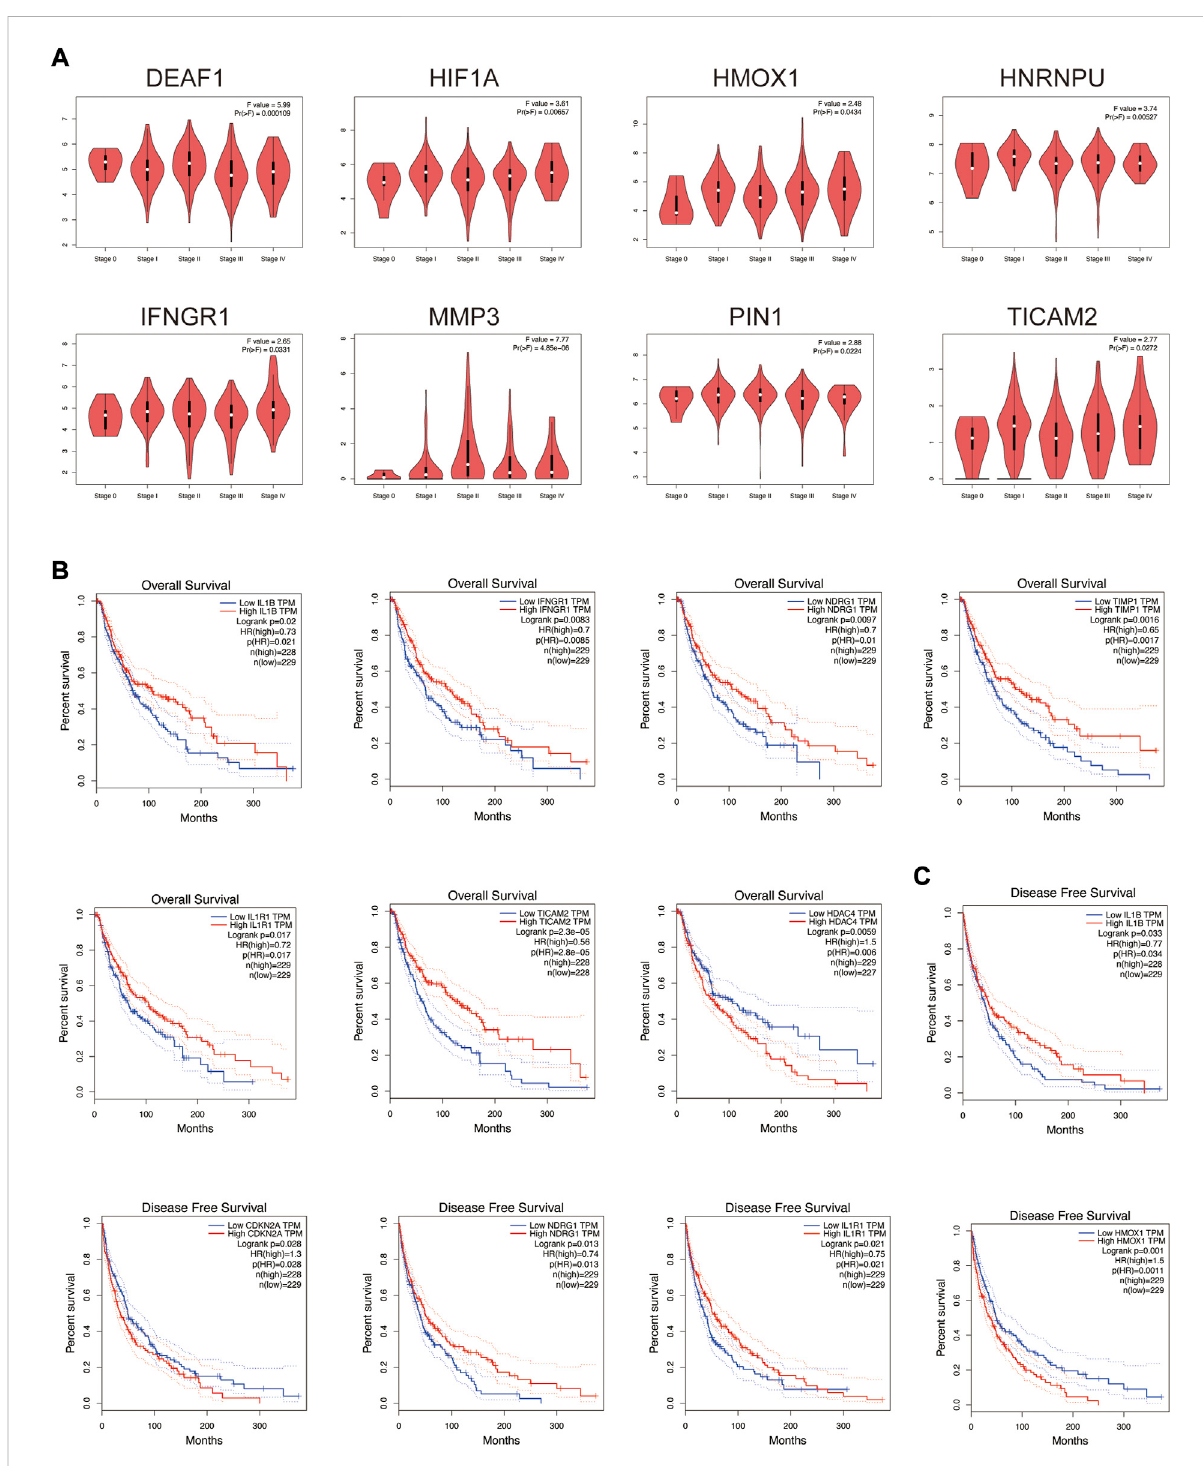
FIGURE 6 Tumorpathologicalstageandmultifacetedprognosticvalueofco-expressiongenesinSKCM. (A) Correlationbetweenthesegenes ’ expression and tumor stage in SKCM patients with GEPIA. (B) The overall survival prognostic value of mRNA level of these genes in SKCM patients. (C) The disease-free survival prognostic value of mRNA level of these genes in SKCM